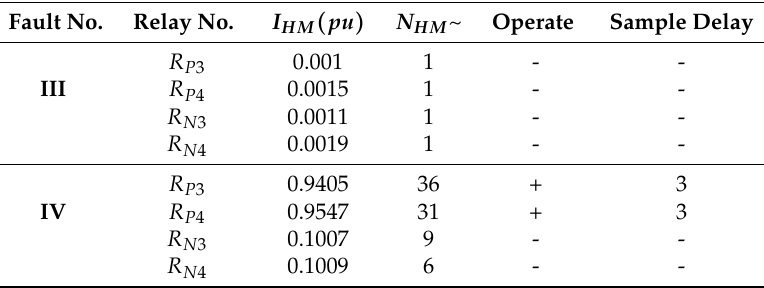
Figure 8. Simulation results for fault IV. ( a ): RP3 current ( b ): RP4 ( c ): Instant amplitude for RP3 ( d ): Instant amplitude for RP4 ( e ): Instant frequency for RP3 ( f ): Instant frequency for RP4. Table 5. Performance of the FCFH protection scheme for case